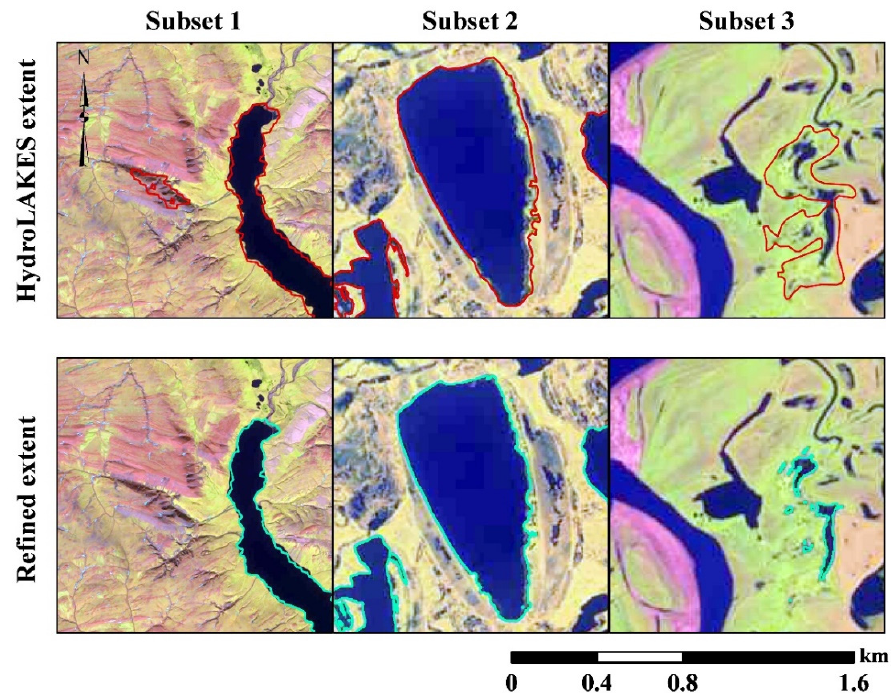
Figure 4. Three typical subsets showing lake shorelines before and after the refinement procedure. The background maps are Sentinel-2 images (shortwave infrared, near infrared, and red bands are displayed in as red, green, and blue layers) acquired on 18 July 2019 for Subset 1 and on 24 July 2019 for Subsets 2–3,